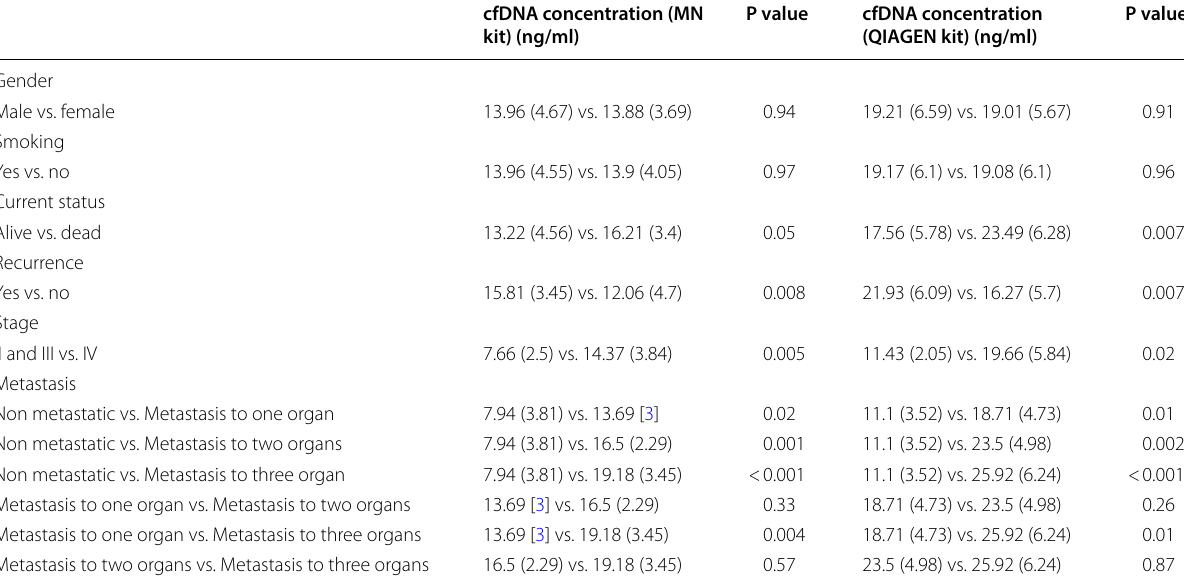
Table 2 Association between cf DNA concentration (ng/mL) and patients’ characteristics